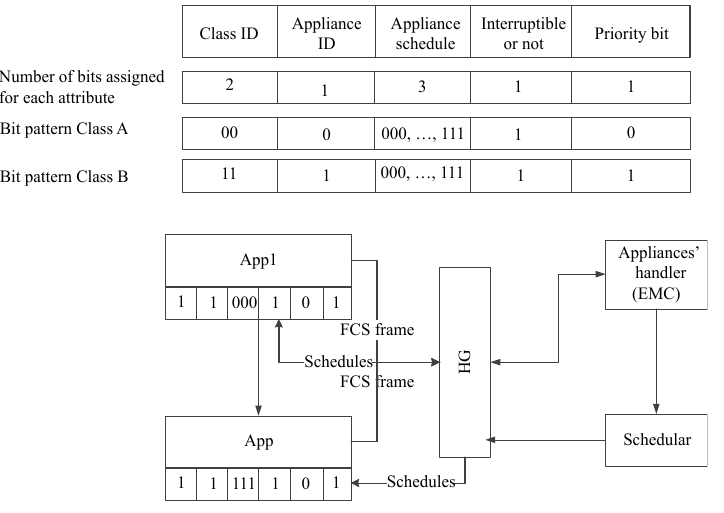
Figure 3. RTP price tracking